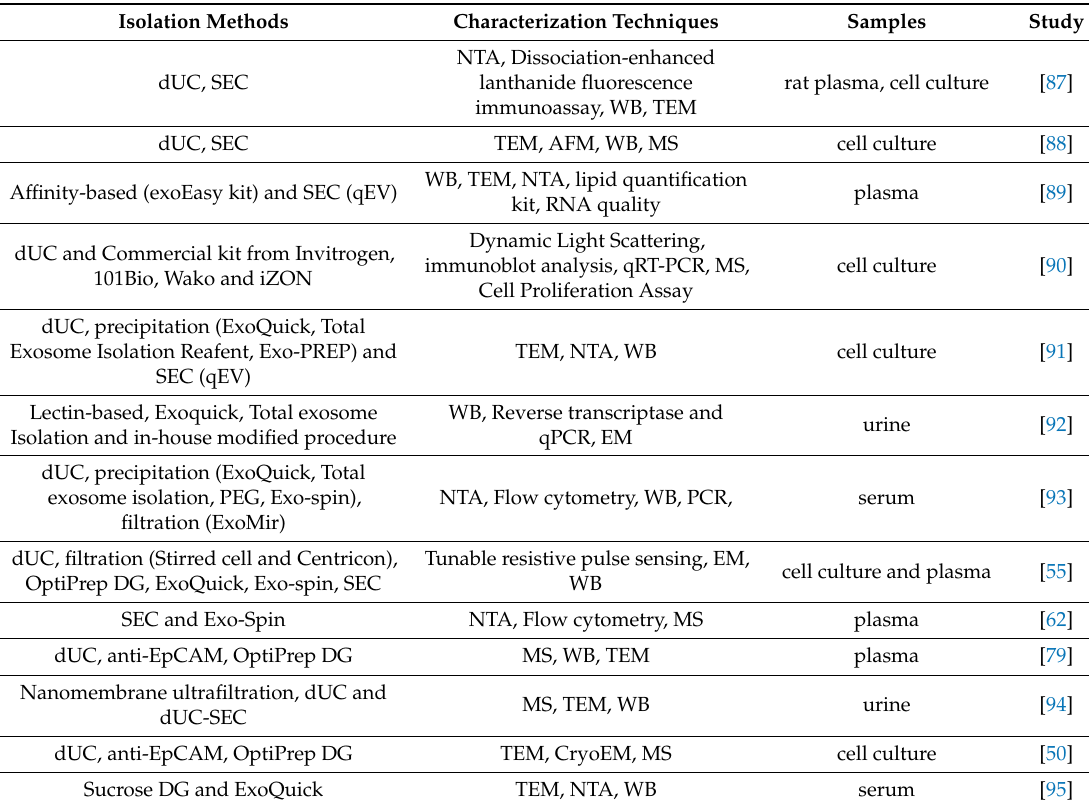
Table 2. Selected comparative studies for EV